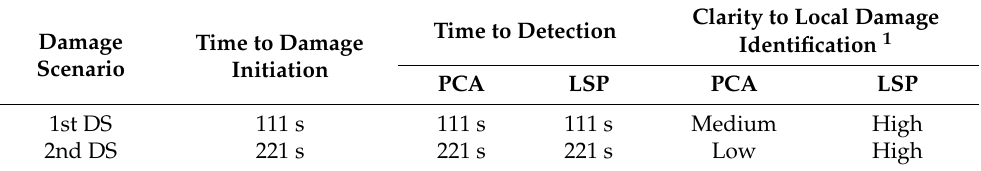
Table 1. Performance of damage detection using WPES-based PCA and LSP